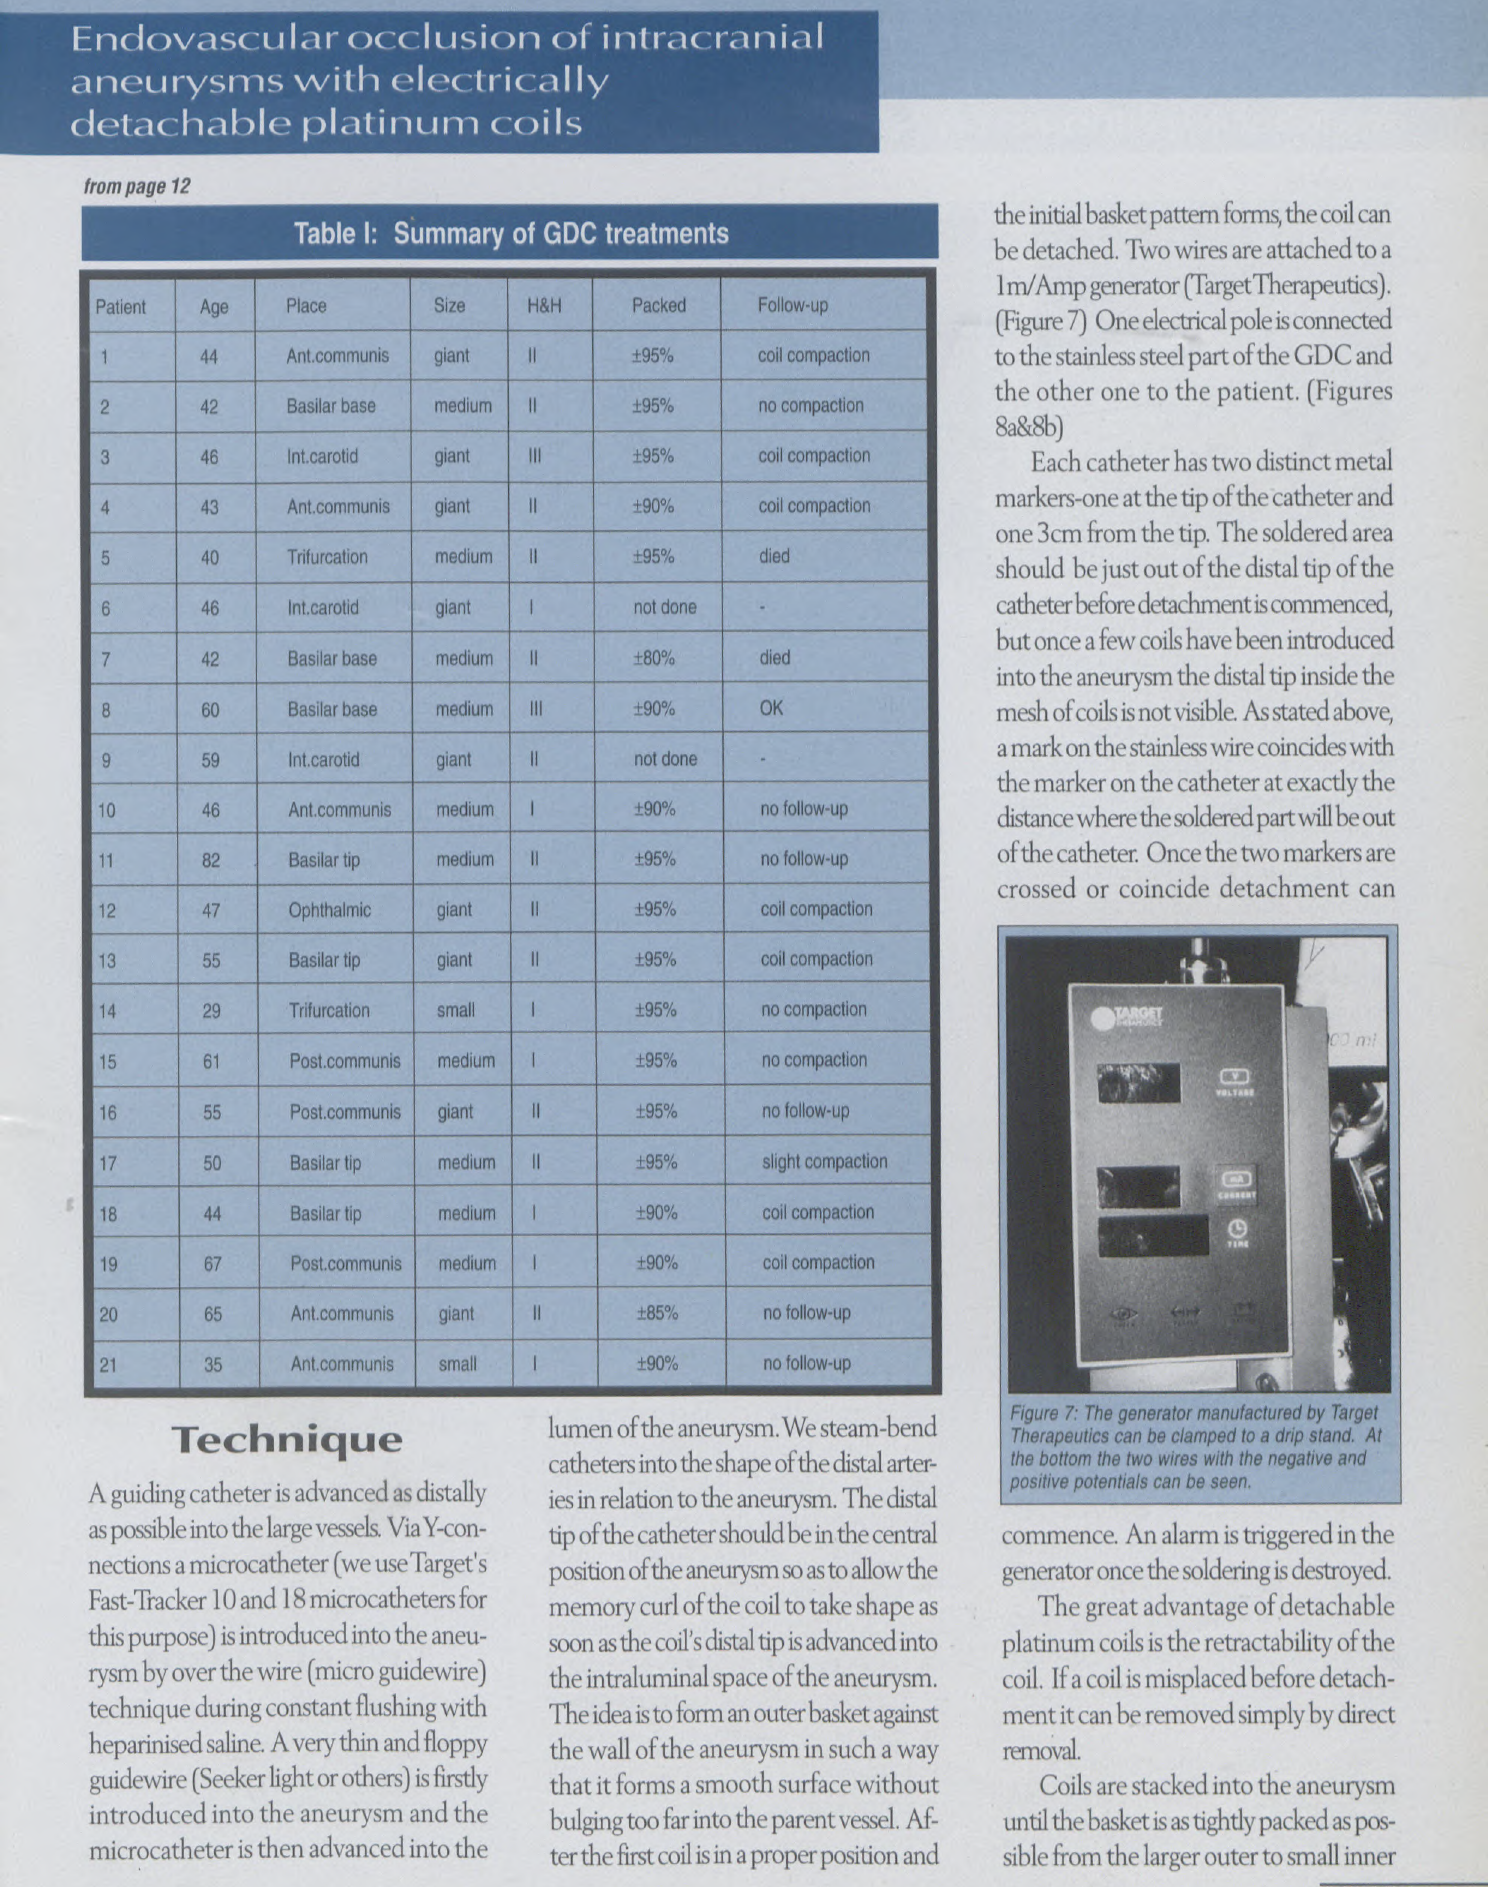
Table I: Summary of GDC treatments